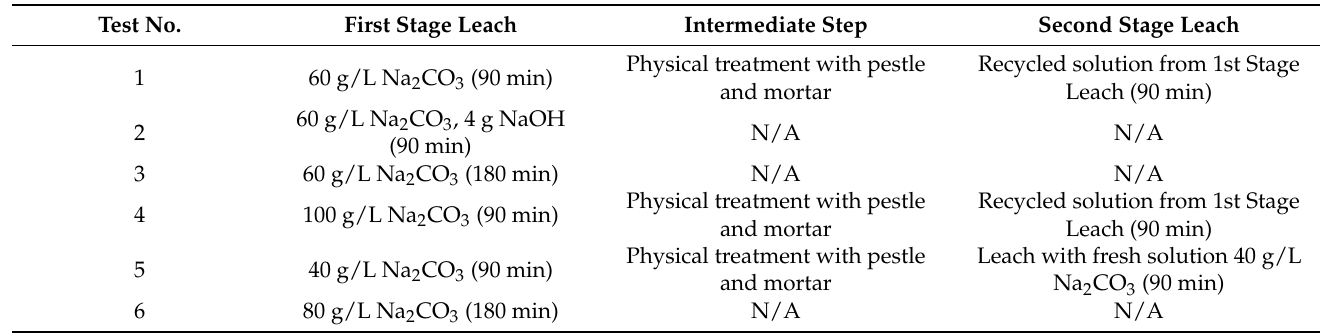
Table 4. Schedule of leaching tests using 100 g slag, 1 l solution, 90 ◦ C leaching temperature, and 500 rpm agitation